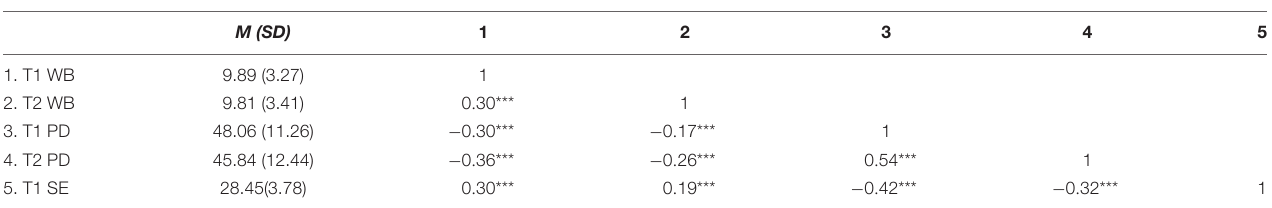
TABLE 1 | Descriptive statistics and partial correlations between variables ( N =